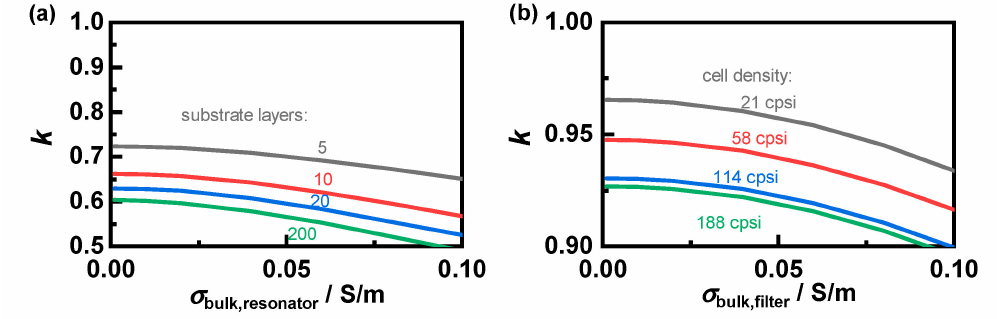
Figure 6. Exponent of the applicable mixing rule k depending on the substrate conductivity σ bulk for ( a ) a different number of substrate layers in the resonator setup, respectively, and ( b ) different cell densities in the filter setup, according to Table 1. Please note: The ordinate axes scaling is enlarged to highlight the